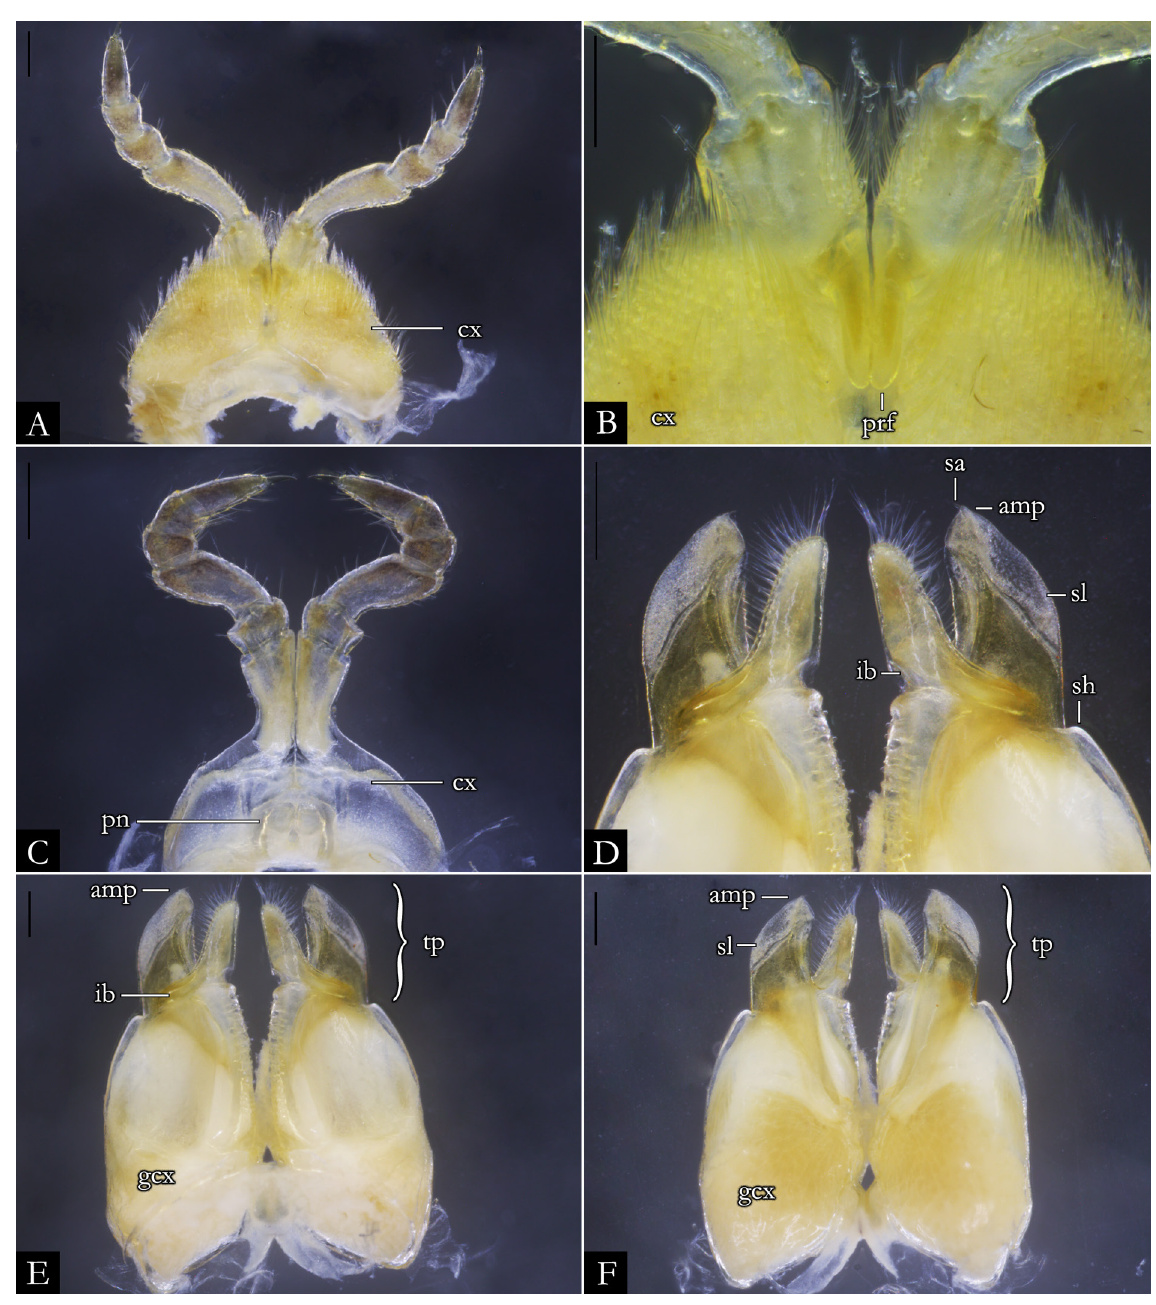
Fig. 150. Pseudonannolene bucculenta sp. nov., ♂ (IBSP 3350). A . First leg-pair. B . Detail of prefemur. C . Second leg-pair. D . Detail of telopodites, in anal view. E . Gonopods, in anal view. F . Gonopods, in oral view. Abbreviations: see Material and methods. Scale bars = 0.2